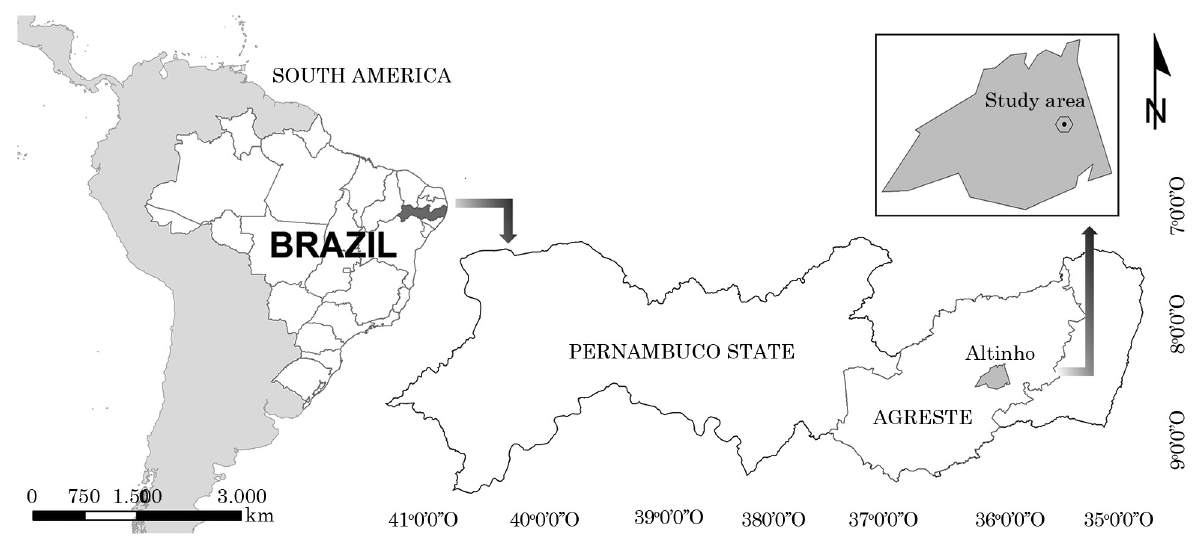
Figure 1. location map of the study area in altinho, municipality of Pernambuco State,